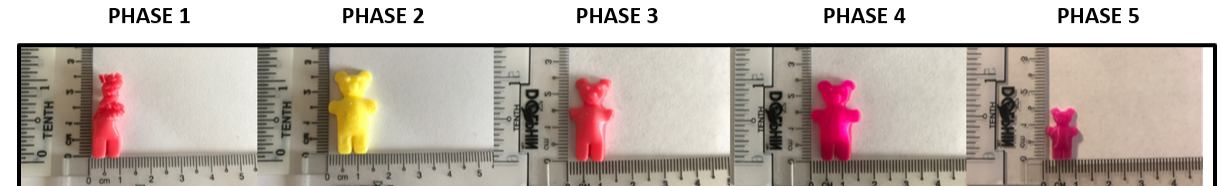
Figure 3. The 2D images of remotely 3D-printed design 4, phases 1 to 5. Table 4. Physical properties of 3D ‐ printed gummy bear shape tablet (design 4). Data for diameter, length, and thickness represent the mean ± standard deviation (SD), where n = 2.